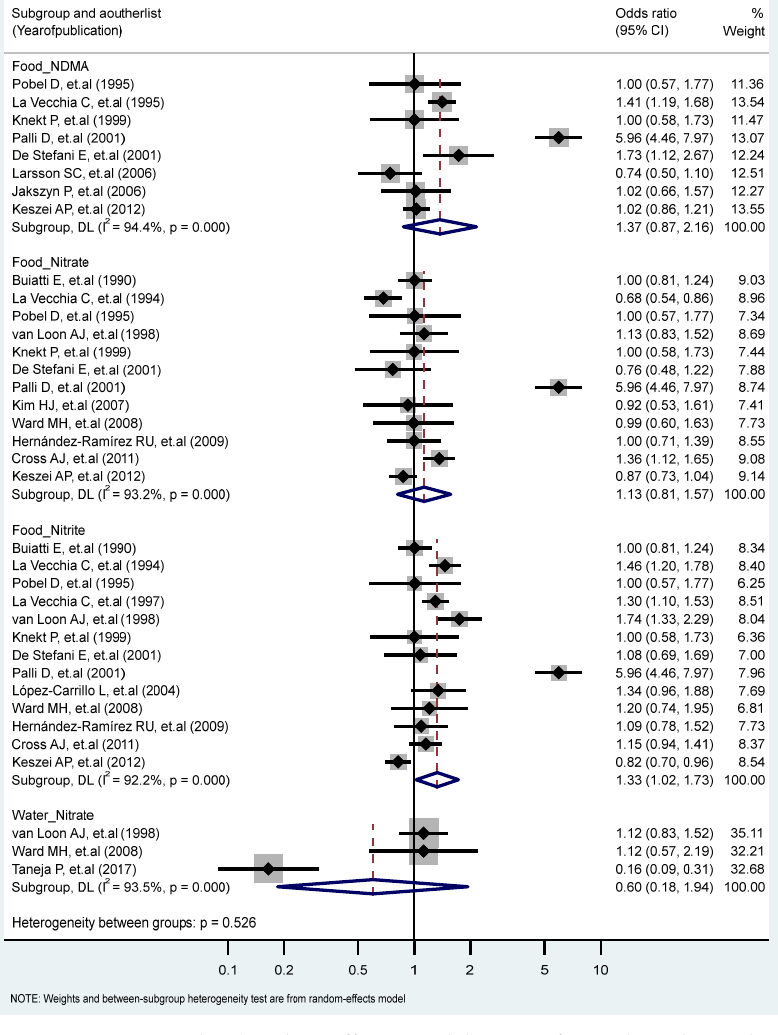
Figure 3. Forest plot (random-effects model) quantifying the relationships between NDMA, nitrite, and nitrate intake and gastric cancer risk stratified by sources. List of references includes: [23–